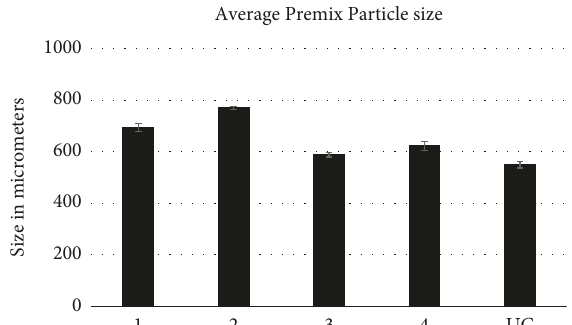
Figure 2: Average particle size in micrometres. Indian premixes 1–3, UofTpositive control 4, and uncoated ferrous fumarate particles